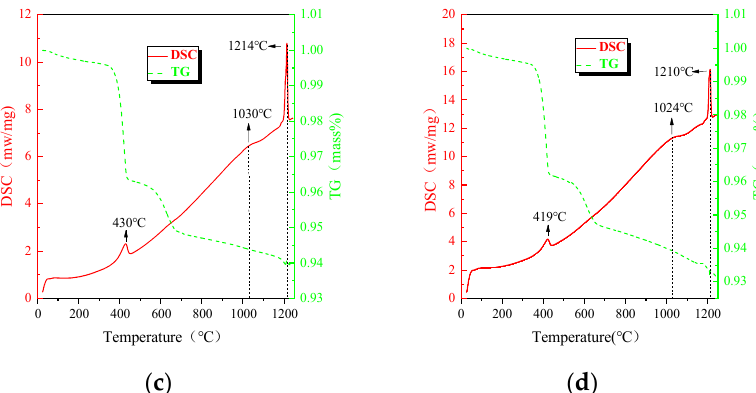
Figure 2. TG-DSC curves of the mixed powders with different Al 2 O 3 concentrations and CF at 50%. ( a ) 0, ( b ) 1.4%, ( c ) 2.8%, ( d ) 4.2%.